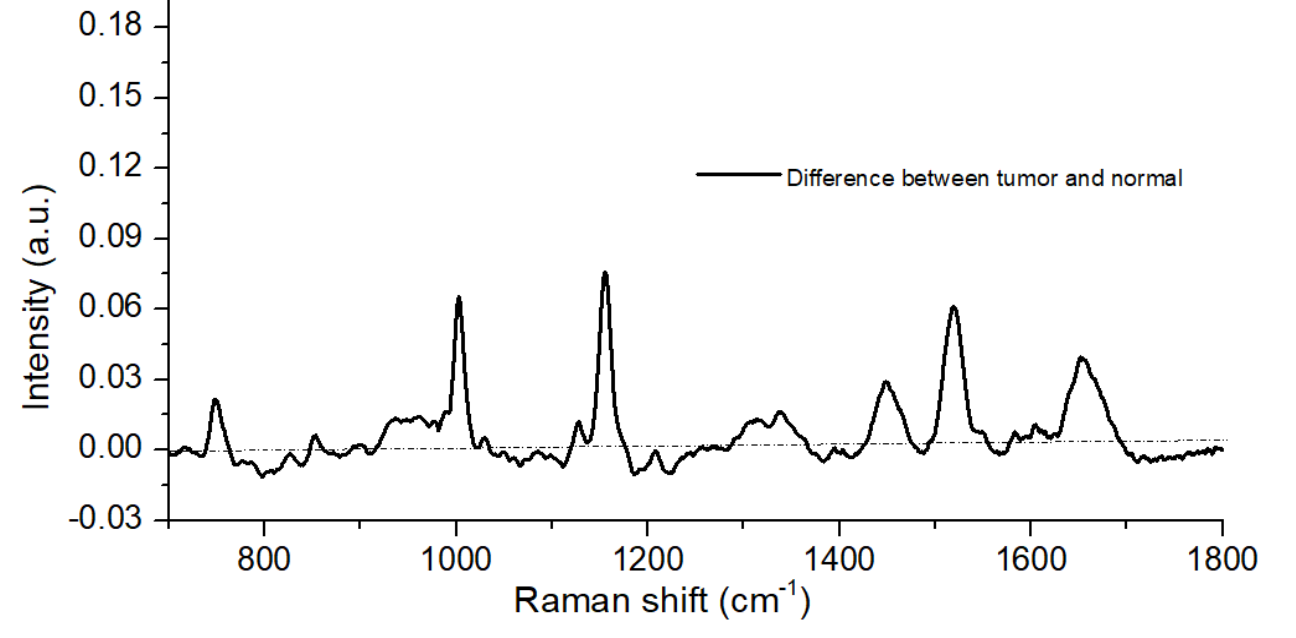
Figure 1. Difference spectra were calculated from the mean spectra (tumor minus